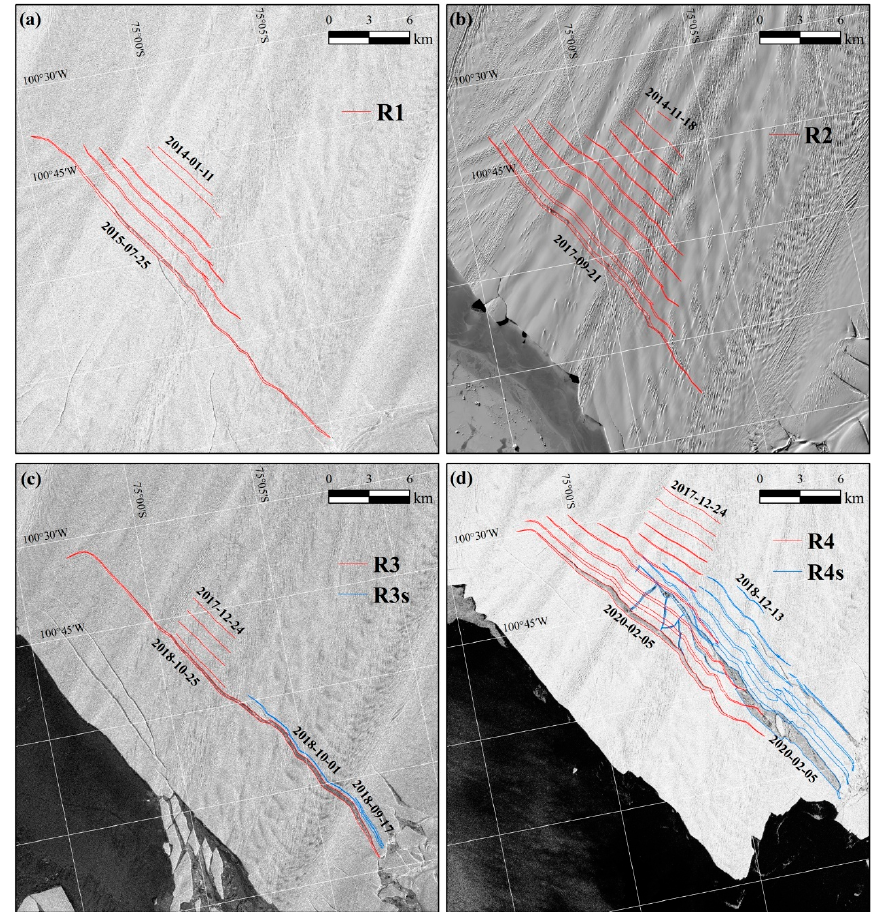
Figure 5. The development of the four rifts. ( a ) The evolution of R1 (background image: Sentinel-1A intensity image acquired on 25 July 2015), ( b ) the evolution of R2 (background image: Landsat-8 OLI image acquired on 21 September 2017), ( c ) the evolution of R3 and R3s (background image: Sentinel-1A intensity image acquired on 25 October 2018), ( d ) the evolution of R4 and R4s (back- ground image: Sentinel-1A intensity image acquired on 5 February 2020).